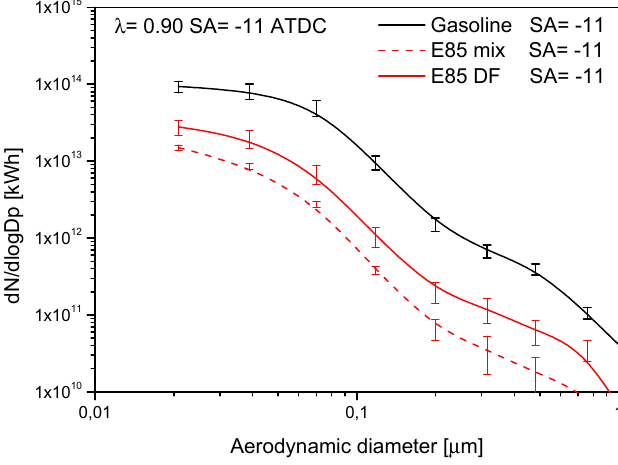
Figure 14. Particle size distribution for λ = 0.9 and SA = − 11 CAD.